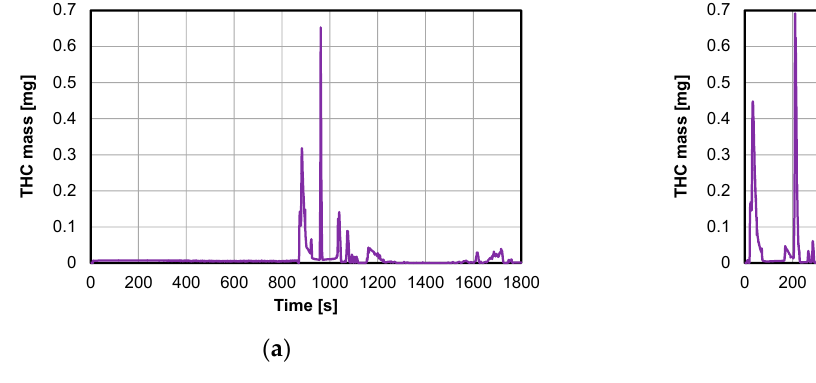
Fuel consumption (FC) during the tests is shown in Figure 21a for the plug-in and in Figure 21b for HEV. In the case of the plug-in in the first half of the test, fuel consumption was equal to zero due to driving with an electric motor. In in the second half, fuel con- sumption varied between the levels of 0 and 0.0002 dm 3 for values of absolute velocity below 20 km/h. Above the latter value, fuel consumption varied between the lower level of 0.0002 dm 3 and the upper one, in which the values increased in a complex, slowly os- cillating-like manner with the increase in absolute velocity. Similar to the case of the plug- in in the second half of the test, fuel consumption also varied in the case of HEV for values of absolute velocity up to 120 km/h. Above the latter, the mentioned lower level was of